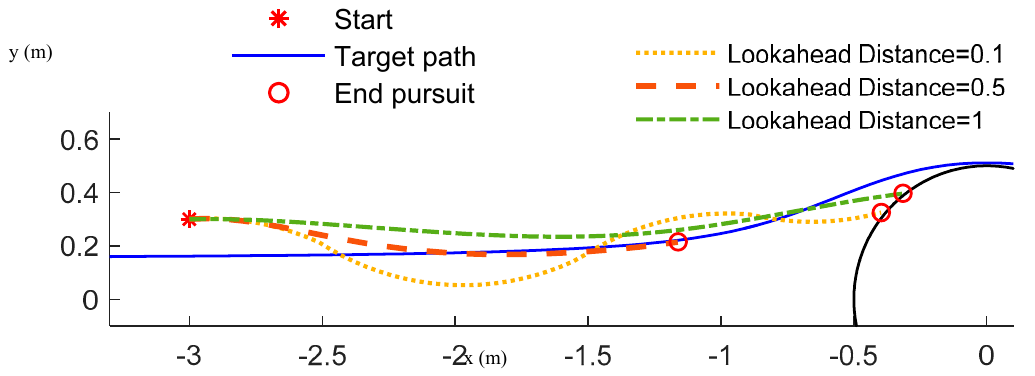
Figure 13. Replanning via pure pursuit paths starting at a fixed position with a set of subgoals determined by different look-ahead distances. The pursuit paths with look-ahead distance 0.1 and 1 intersect with the obstacle, while the pure pursuit path with a look-ahead distance of 0.5 is collision- free.